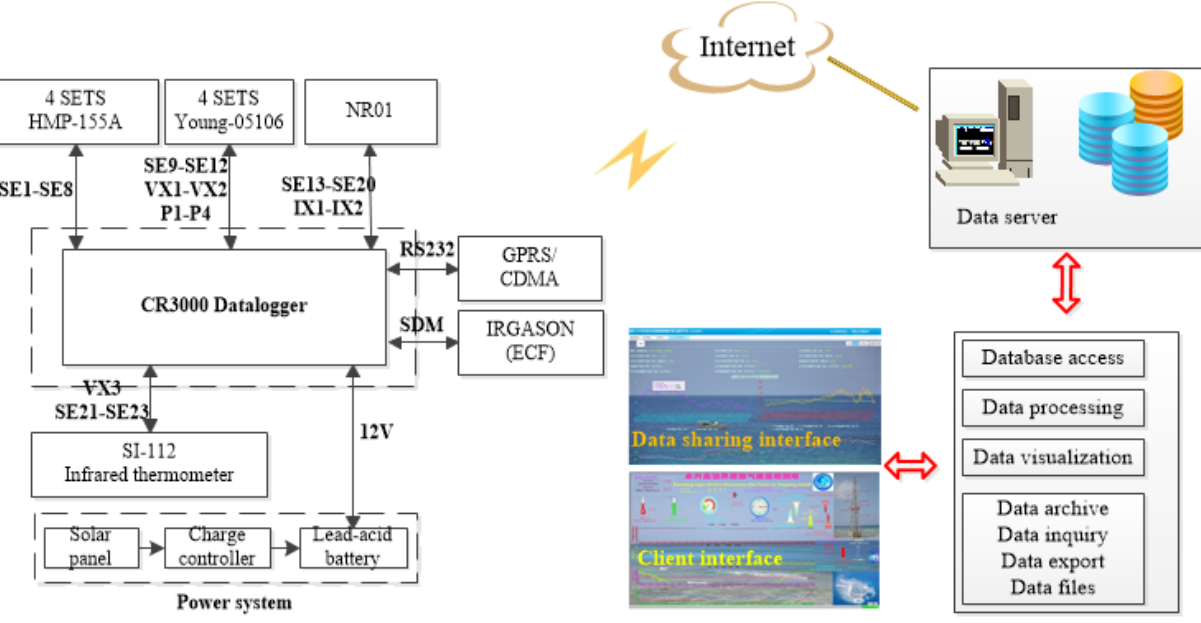
Figure 2. Diagram of the real-time data acquisition system and the sensor wiring scheme on the YXASFT (SE: single-ended channel, VX: voltage excitation channel, P: pulse-input channel, IX: current excitation channel, SDM: SDM channel, GPRS: General Packet Radio Service, CDMA: code-division multiple access; Campbell Scientific, Inc.,